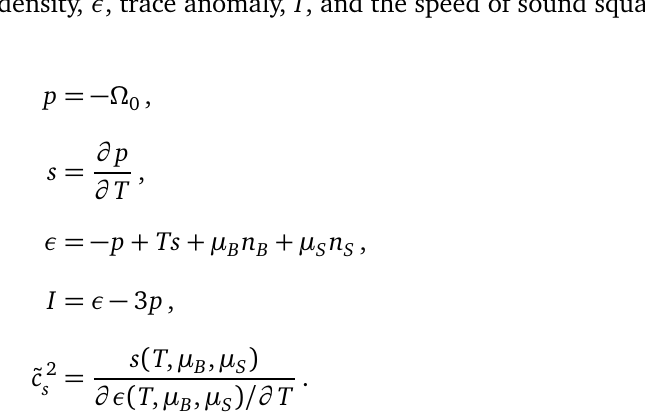
Figure 2: The pressure p , the baryon number density n / T = 2 and µ = 0 in comparison to lattice results as a function of the n at µ S B S rescaled temperature t . The lattice data is taken from [ 8 ]